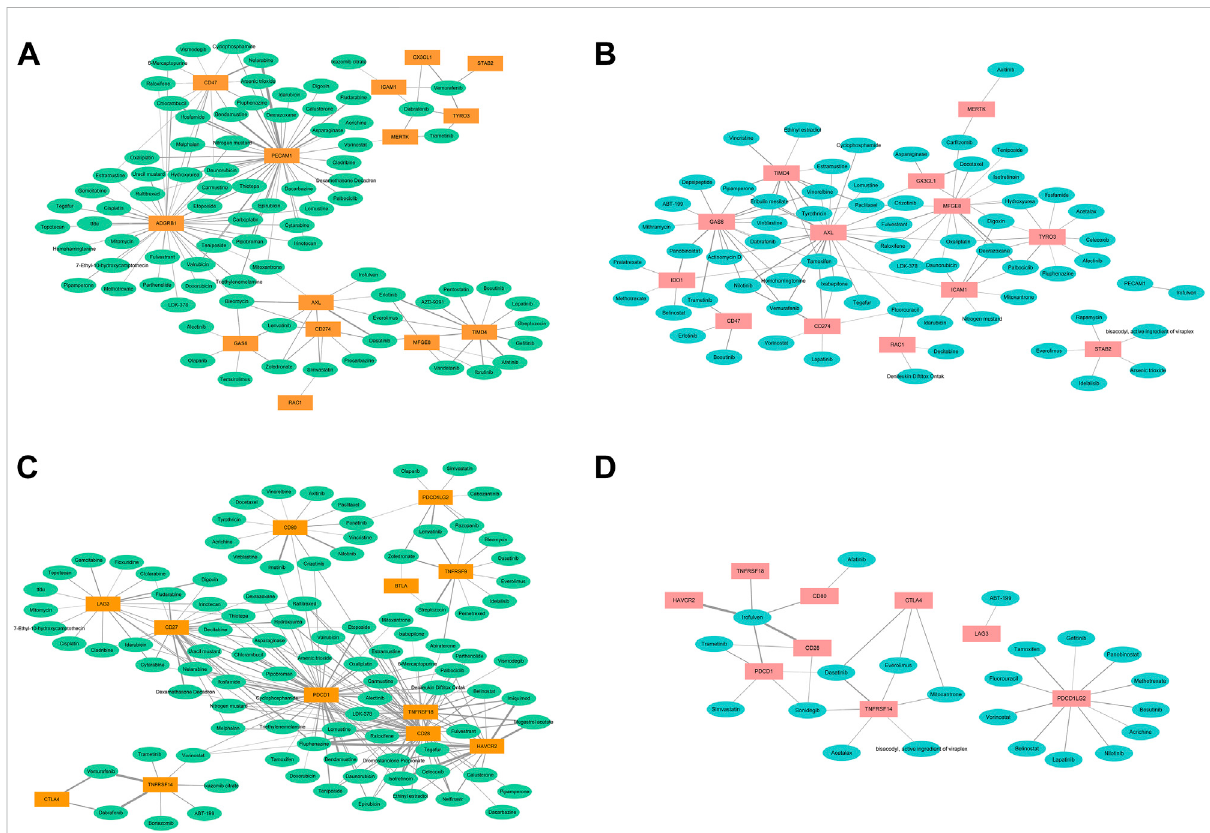
FIGURE 5 The correlations of the expressions of efferocytosis and immune checkpoint related molecules with sensitivity of the cancer cells to the 126 types of anti-cancer drugs. The thickness of the line indicates the size of the correlation coef fi cient. (A) . The correlations of the enhanced expressions of 14 efferocytosis-related molecules with increased sensitivity to anti-cancer drugs. (B) The correlations of the enhanced expresssions of 14 efferocytosis-related molecules with decreased sensitivity to anti-cancer drugs. (C) The correlations of the enhanced expressions of 12 immune checkpoint-related molecules with increased sensitivity to anti-cancer drugs. (D) The correlations of the enhanced expressions of 9 immune checkpoint-related molecules with decreased sensitivity to anti-cancer